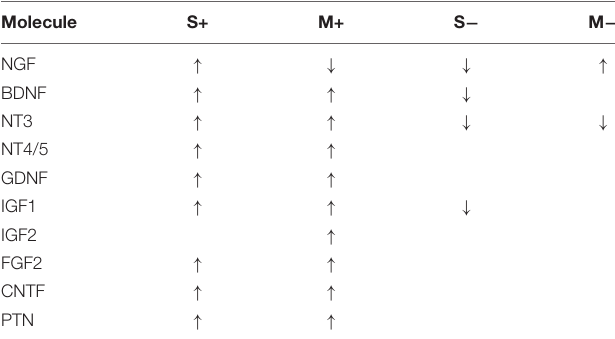
TABLE 2 | Effects of the supply (+) or depletion ( − ) of axonal growth-promoting molecules in the surrounding tissue of sensory (S) or motor (M)